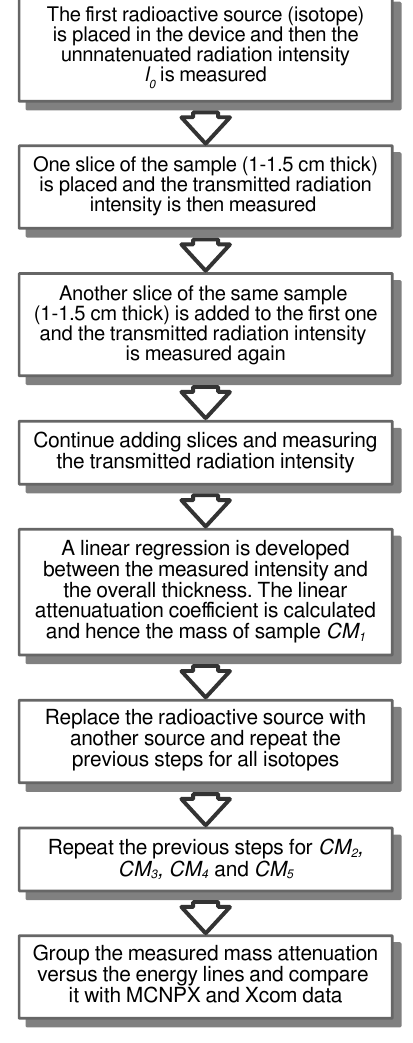
Figure 2: A flowchart describing the steps followed in the experiment to measure the mass attenuation coef-